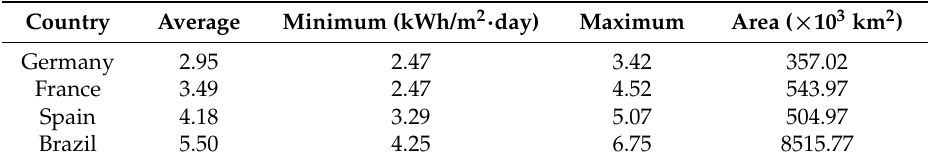
Table 4. Daily solar irradiance and area by country.